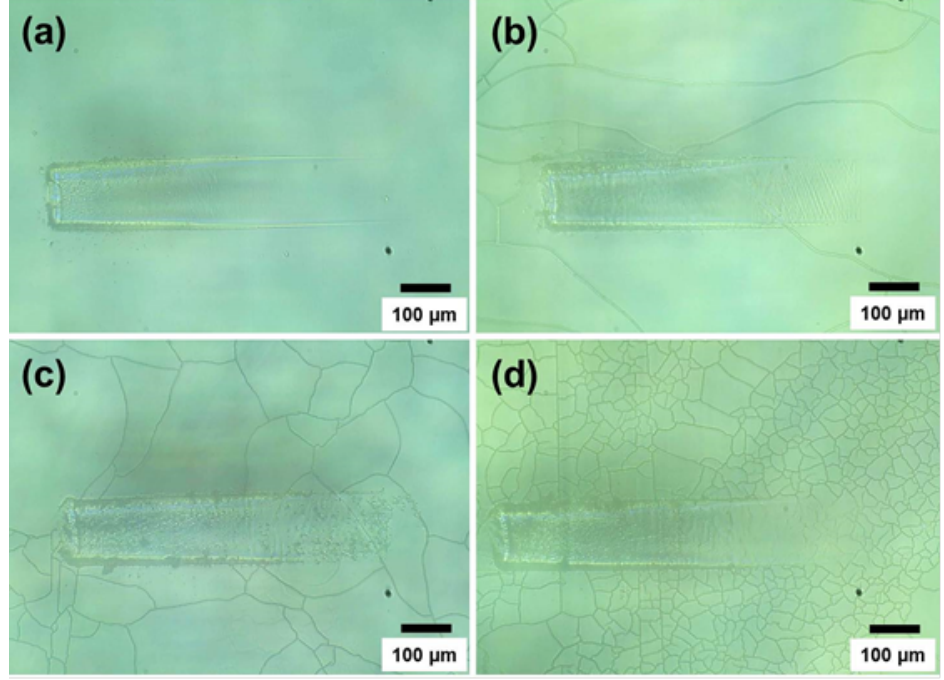
Figure 9. Adhesion test performed on the coatings prepared from ( a ) 7; ( b ) 10; ( c ) 15; and ( d ) 20 vol% of SiO in TiO 2 2